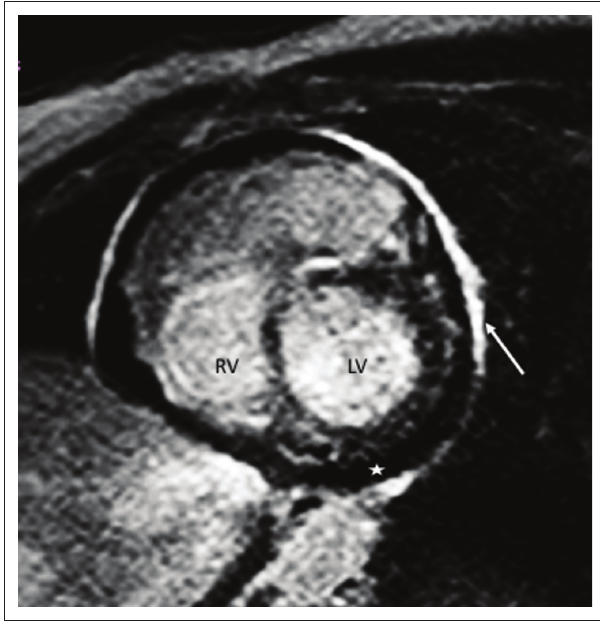
RV, right ventricle; LV, left ventricle. FIGURE 4: A 54-year-old woman with biopsy-proven cutaneous sarcoidosis. The late gadolinium enhancement image in the short-axis orientation demonstrates the pericardial effusion ( * ) as well as avid pericardial enhancement (white arrow).